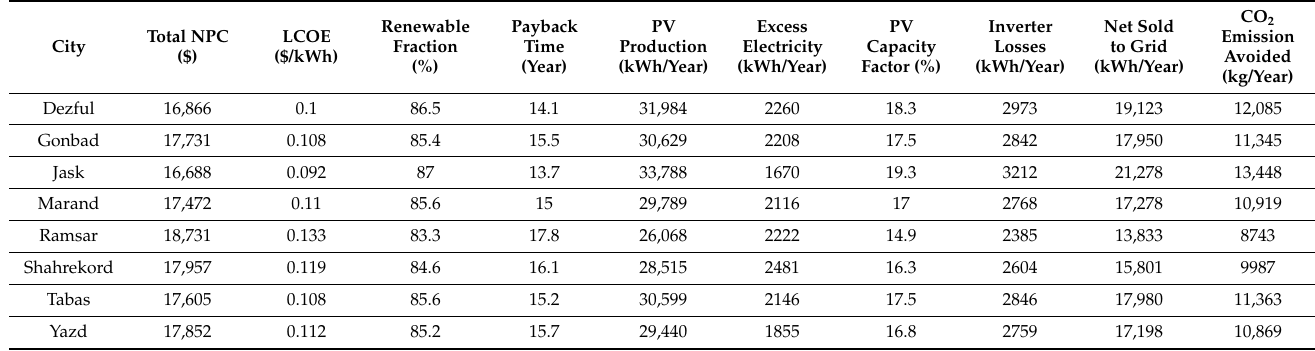
Table 6. Results of slope 60 ◦